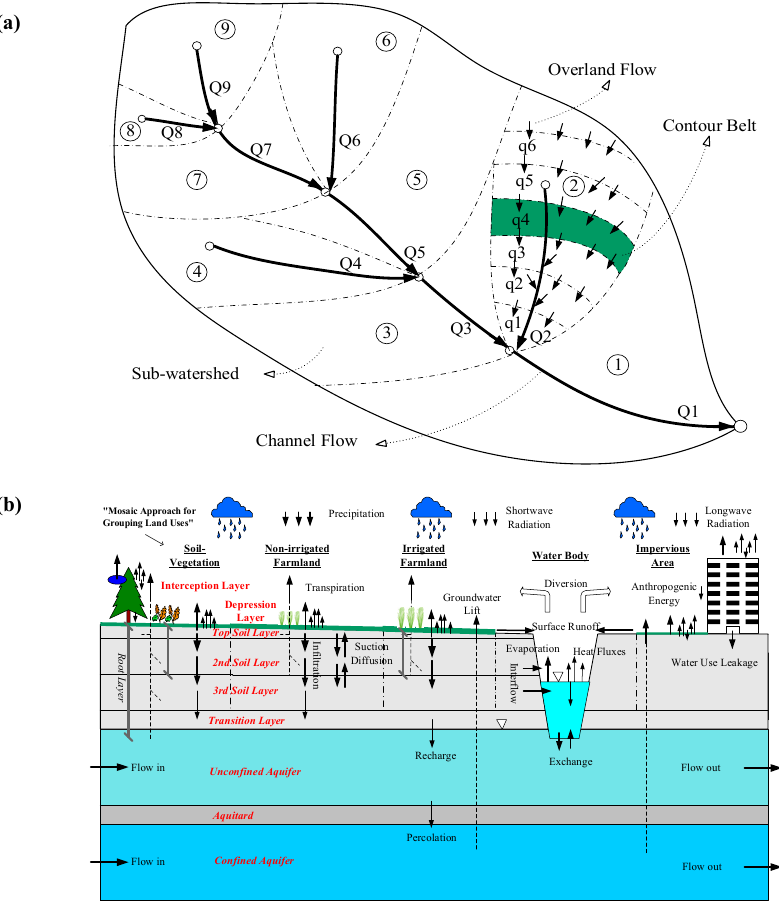
Figure 4. Schematic illustration of distribution structure of Water and Energy transfer Processes model for Large river basins (WEP-L model): ( a ) horizontal structure and ( b ) vertical structure.